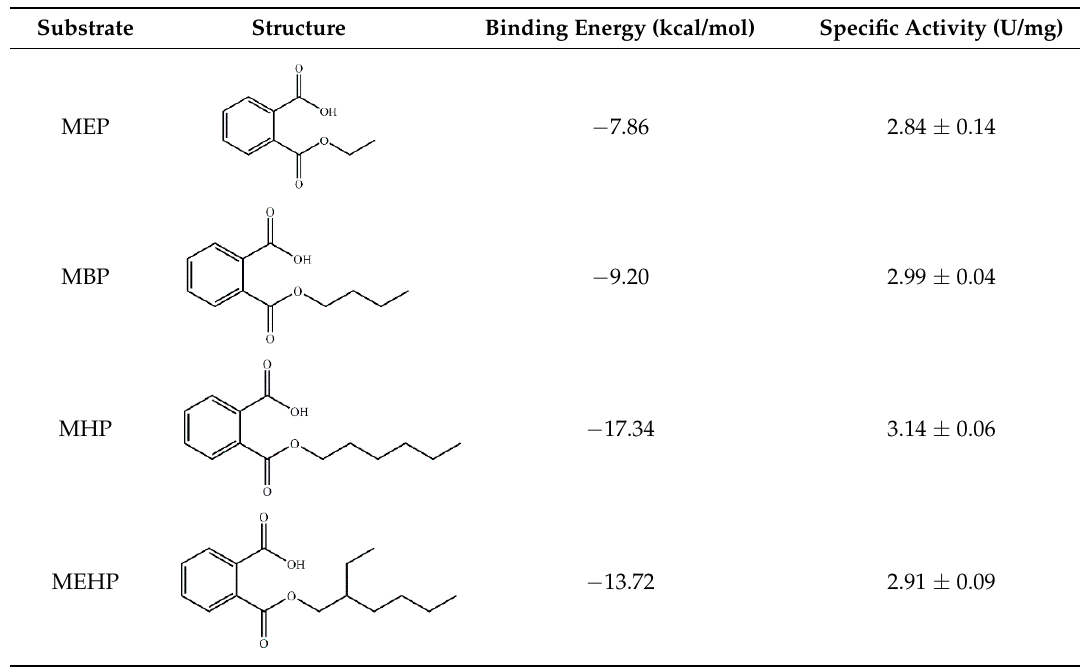
Figure 4. Analysis of expression and purification of recombinant MphG1 by Sodium dodecyl sulfate polyacrylamide gel electrophoresis (SDS-PAGE). Lane M, protein molecular mass marker; lane 1, total protein of ArcticExpress (DE3) harboring pET- mphG1 without induction; lane 2, total protein of ArcticExpress (DE3) harboring pET- mphG1 induced by IPTG; lane 3, the supernatant of ArcticExpress (DE3) harboring pET- mphG1 induced by IPTG; lane 4, purified recombinant MphG1. Table 1. The binding free energy after molecular dynamics (MD) simulation and specific activity of MphG1 towards monoalkyl phthalates (MAPs).